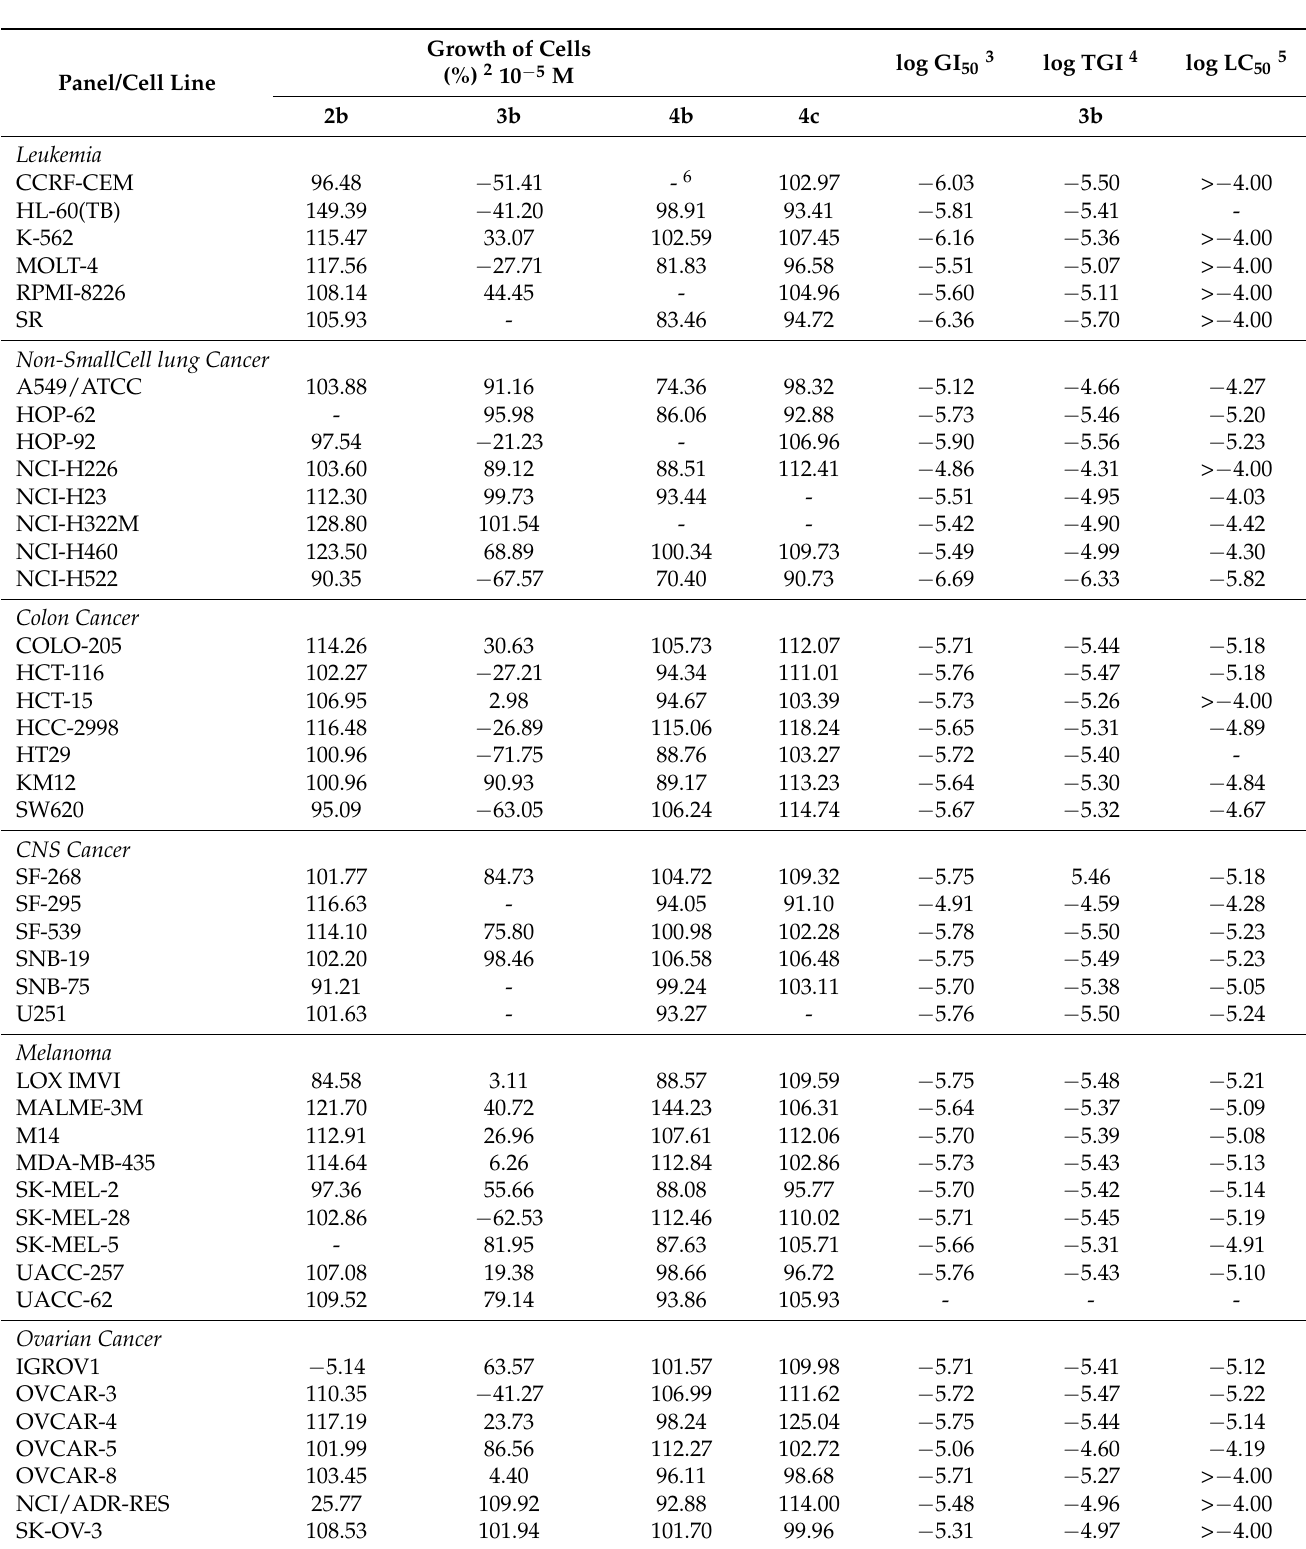
Table 3. In vitro anticancer activity for compounds 2a , 3b , 4b and 4c against 60 human cancer cell lines 1